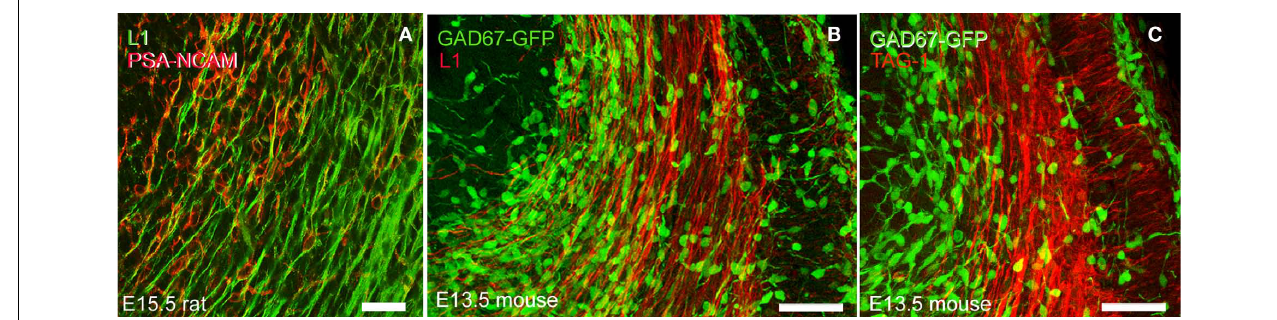
FIGURE 9 | The microanatomical proximity of migratory interneurons with L1 + and TAG-1 + axons. (A) PSA-NCAM + migratory interneurons associated with L1 + axons in an E15.5 rat. (B) GAD67-GFP + migratory interneurons in E13.5 mice in contact with L1 + axons. In both species, the bulk of migratory GABAergic interneurons exiting from the ganglionic eminences occupied a medial territory, where they overlapped with L1 + axons. A less dense population of migrating interneurons located more laterally also